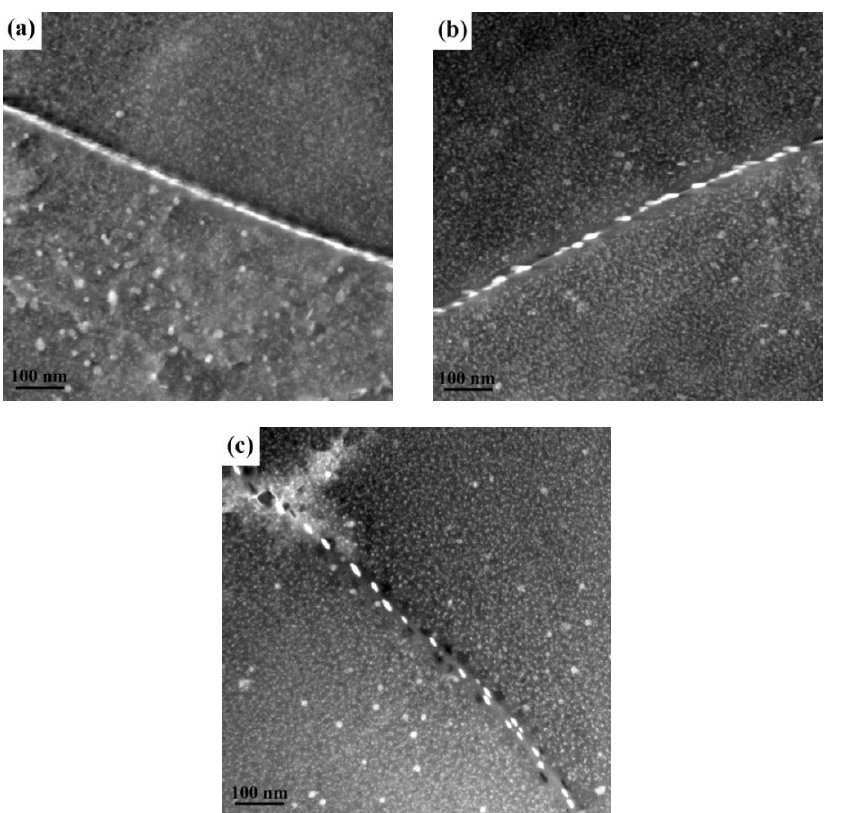
Figure 5. STEM images (ED – TD plane) of precipitated phase at grain boundaries of alloys with different Zn/Mg ratios: ( a ) 1# alloy; ( b ) 2# alloy; ( c ) 3# alloy.